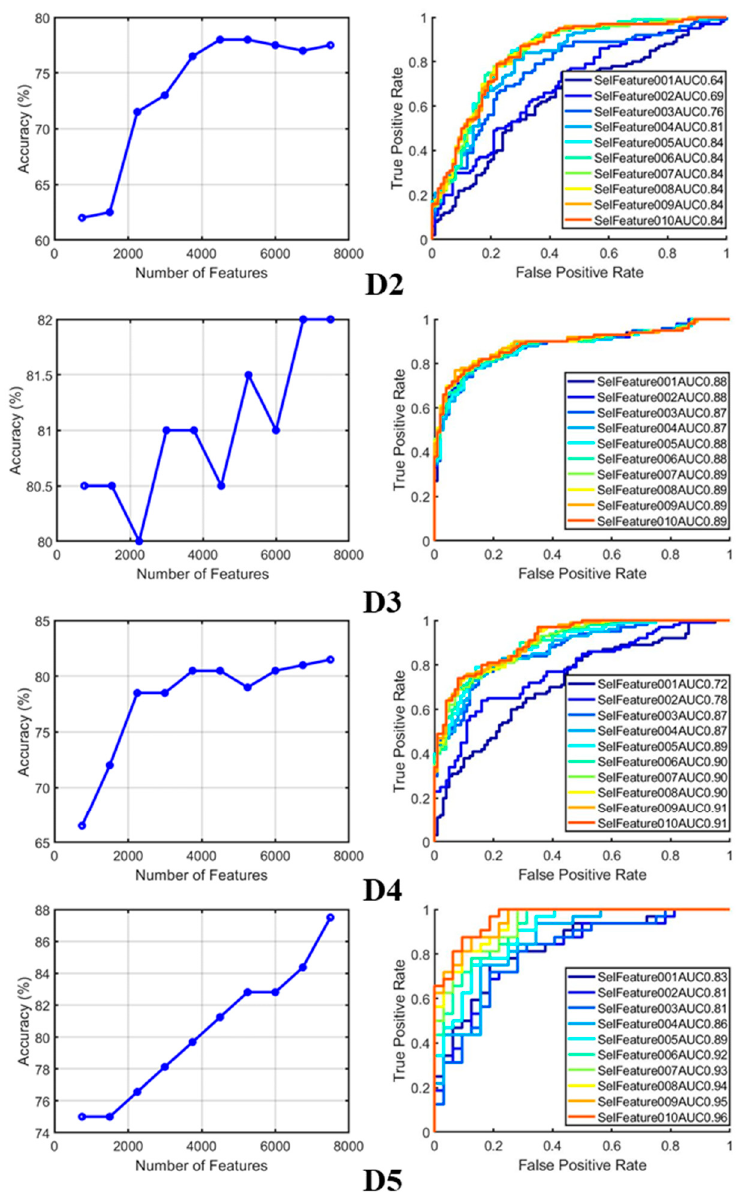
Figure 8. Comparison of F-score feature selection results.